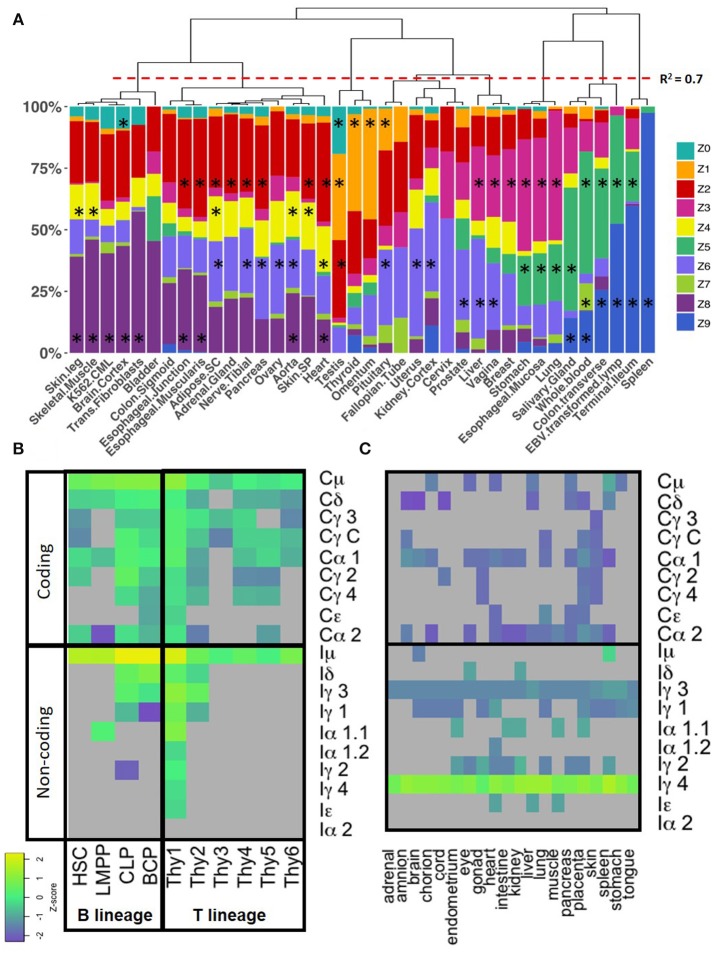
CSRnc transcription profile variation in healthy tissue. (A) The GTEX dataset was categorized according to tissue (x axis) and the relative proportion of samples (y-axis) belonging to each Z cluster (in colors). Many central nervous system tissues with highly similar pattern were removed for simplicity. Proportions were hierarchically clustered using Pearson correlation as distance metric with Cluster3.0 (18). The red dotted line marks a correlation R2 = 0.7. The black asterisk indicates a significant enrichment of a given tissue in a particular Z cluster (Exact Fisher's test, Benjamini-Hochberg adjustment for multiple correction. FDR < 0.01). (B) CSRnc (rows, lower panel) and CH (rows, upper panel) transcription in B (columns, left panel) and T cell precursors (columns, right panel). Z-score heatmap of IH and CH transcription in bone marrow from hematopoietic stem cells (HSC, CD34+CD38−lin−), lymphoid multipotent progenitors (LMPP, CD34+CD45RA+ CD38+CD10−CD62Lhilin−), common lymphoid progenitors (CLP, CD34+CD38+CD10+CD45RA+lin−), and committed B cell progenitors (BCP, CD34+,CD38+,CD19+) are shown in the left panel. CSRnc and CH transcription in thymic lymphoid precursors in thymic early lymphoid precursors with myeloid potential Thy1 (CD34+CD7− CD1a− CD4−CD8−) and Thy2 (CD34+CD7+CD1a− CD4−CD8−), as well as, fully committed T cell precursors Thy3 (CD34+CD7+CD1a+CD4− CD8−), Thy4 (CD4+CD8+), Thy5 (CD3+CD4+CD8−), and Thy6 (CD3+CD4− CD8+). Data was obtained from study SRP058719 (40). Each value represents the mean ± SD of two biological replicates. (C) CSRnc IH and CH transcription in fetal tissues from study SRP055513 (41). Heatmap of Z-score average per tissue (n = 3–8) of IH and CH (rows) in 9–22 weeks of gestation fetal tissues (columns). Higher transcription (Z-scores) are shown in green-yellow, lower expression and no expression is shown in purple and gray, respectively. Higher than average expression of Iγ4 is observed in all tested tissues. Z-score color code as in (B).